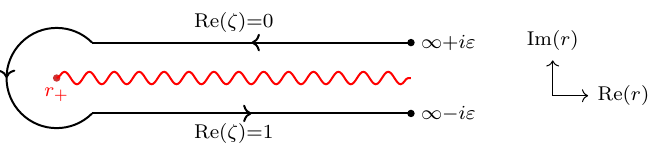
Figure 11. The complex r plane with the locations of the two boundaries and the horizon marked. The grSK contour is a codimension-1 surface in this plane (drawn at fixed v ). The direction of the contour is as indicated counter-clockwise encircling the branch point at the